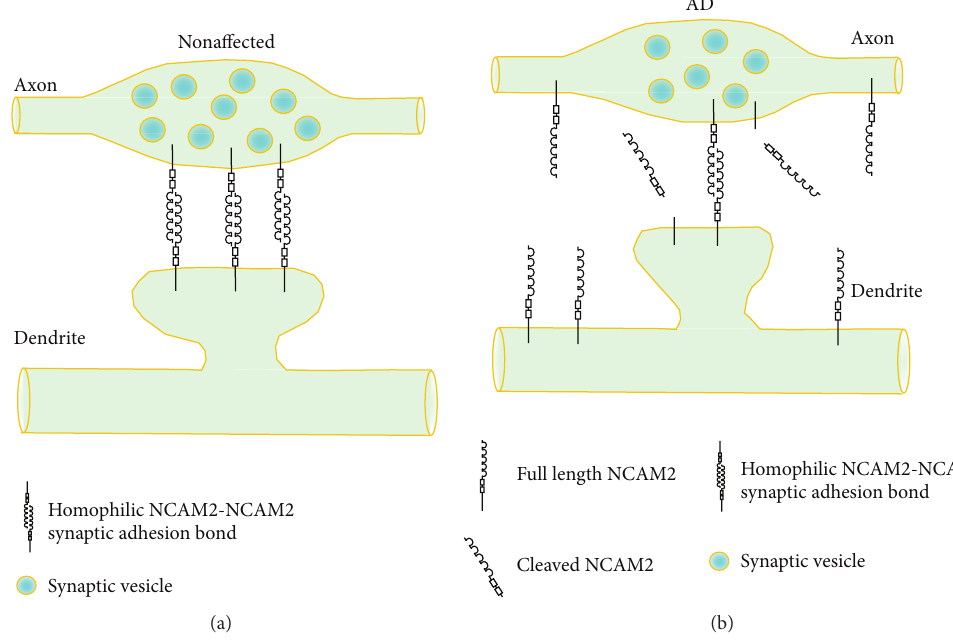
Figure 2: Changes in NCAM2-mediated synaptic adhesion in AD-affected hippocampus. In AD-nonaffected hippocampus (a), NCAM2 accumulates in synapses and plays a role in the synapse maintenance. In AD-affected hippocampal synapses (b), levels of full length NCAM2 are decreased. This decrease is accompanied by an increase in the levels of the proteolytic cleavage products of NCAM2. The overall expression of NCAM2 is also increased probably due to the increase in the levels of extrasynaptic NCAM2.